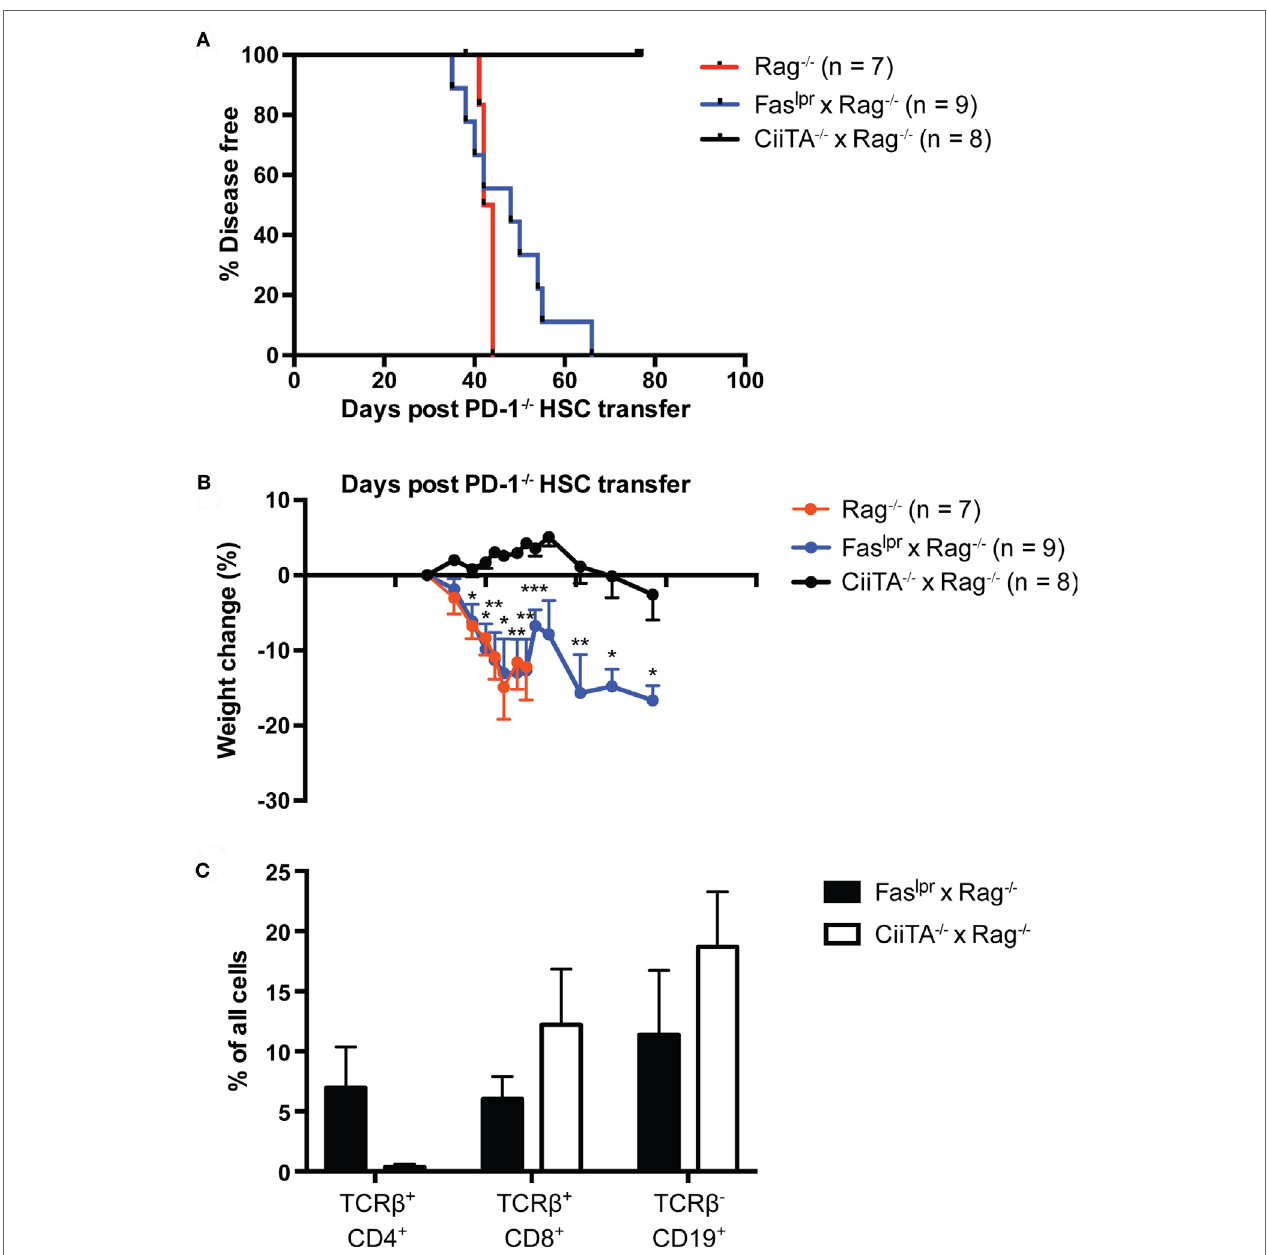
FigUre 3 | Systemic autoimmunity in lymphopenic PD-1 − / − hematopoietic stem cells (HSC) recipients requires host MHC Class II but not Fas. PD-1 − / − HSC were transferred to Rag − / − , Fas lpr × Rag − / − , or CiiTA − / − × Rag − / − recipients and mice were monitored for disease symptoms. (a) Kaplan–Meier survival curve analysis of disease incidence among HSC recipients—groups are significantly different with p = 0.0002. Data are combined from two independent experiments, with starting numbers per group indicated in the legend. (B) Weight changes in recipients relative to day 27 post-transfer, combined from two independent experiments, ± SEM. Weight observations for which similar time points were available between experiments ( ± 2 days) were combined. For each timepoint, only data from groups with n > 2 are presented. * p < 0.05, ** p < 0.01, *** p < 0.001, Fas lpr × Rag − / − vs. CiiTA − / − × Rag − / − , one-way ANOVA with Tukey or Kruskal–Wallis with Dunn’s multiple comparison test (days 27–49) or Student’s t -test (day > 51). (c) % of all peripheral blood cells that were CD4 + or CD8 + T cells or CD19 + B cells in Fas lpr × Rag − / − and CiiTA − / − × Rag − / − recipients from one experiment in (a,B) above, measured at day 46 post-HSC